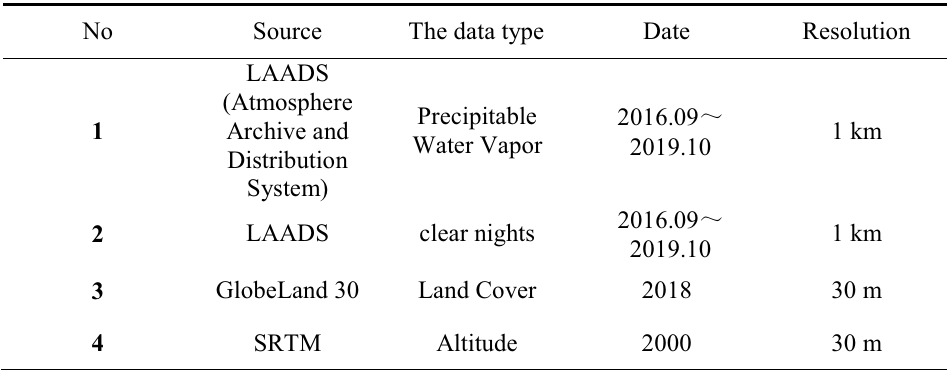
Table 1. Dataset of the study